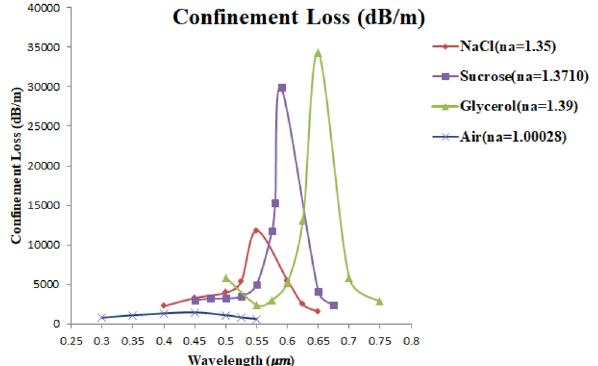
Figure 20. The confinement loss α CL (dB/m) for air, NaCl-DI water, sucrose-DI water, and glycerol-DI water as a function of wavelength.